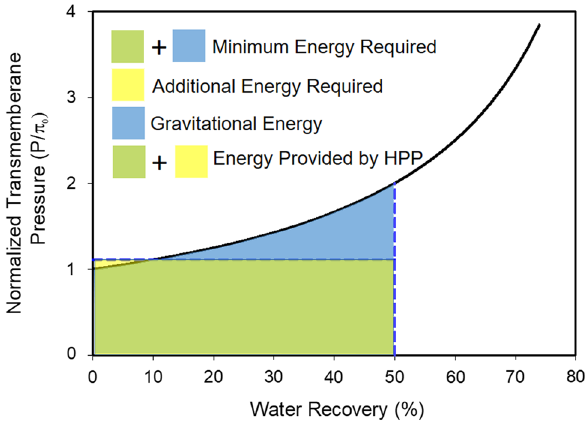
Fig. 7 Theoretical transmembrane pressure normalized to the differ- ence in the osmotic pressure of seawater and the permeate for a grav- ity-assisted five-stage RO with 10% water recovery at each stage. The HPP provide a pressure of 1.11 𝜋 0 to the first state. The added pressure to stages 2 through 5 is due to the gravitational force with each stage located at a height to generate 10% recovery. The specific energy SE = 1.178 kWh/m 3 is represented by the sum of the areas shaded green, blue, and